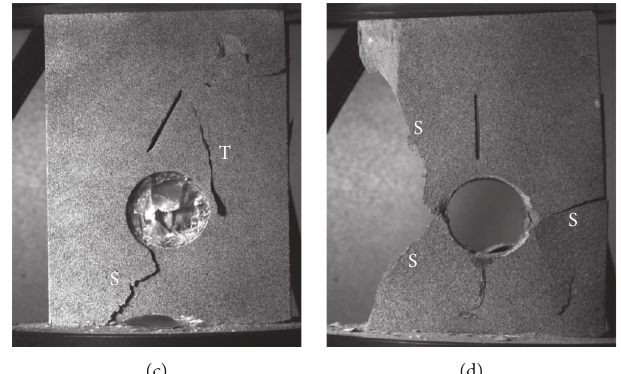
Figure 9: Typical failure mode observed in the present experiment (T: tensile crack; S: shear crack). (a) Mode I, (b) Mode II, (c) Mode III, and (d) Mode IV.